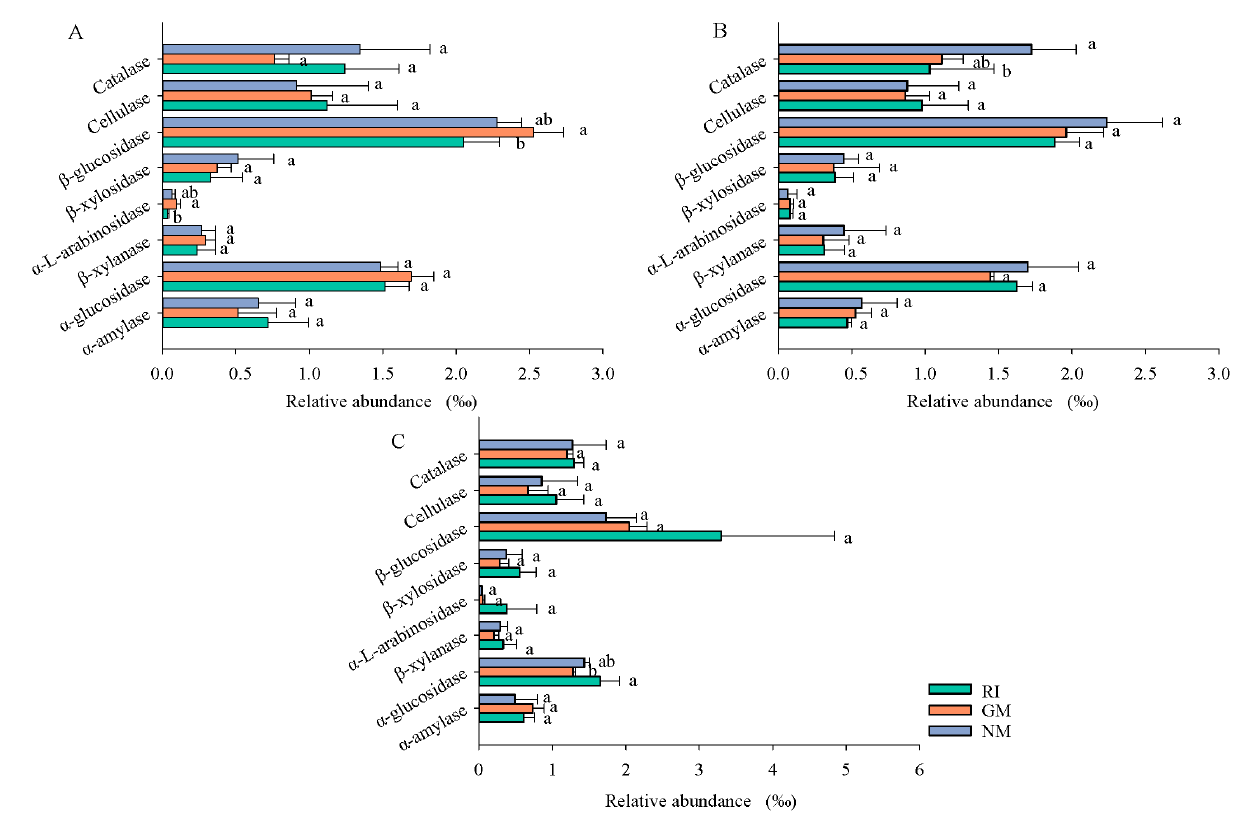
Figure 5. Effects of AM fungi on functional characteristics of bacterial community were predicted based on PICRUSt2 analysis under CK ( A ), Cd ( B ), and Pb ( C ) treatments. Different lowercase letters represent significant differences ( p < 0.05).